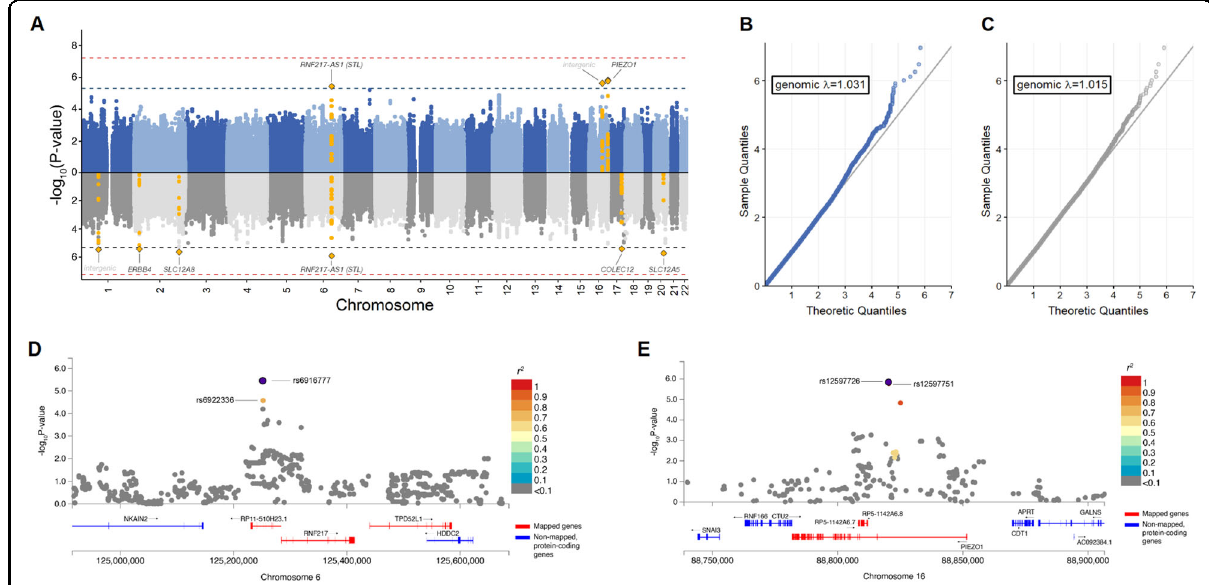
Fig. 2 Primary analysis results. A Results from the SNP-based, genome-wide association study for remission status (top panel in blue) and percentage symptom improvement (bottom panel in grey). B Q – Q plots for association p-values with remission status. C Q – Q plots for association p-values with percentage symptom improvement. D Locus zoom plot of chromosome 6 top-associated locus surrounding rs6916777 (chr6:25251374:C:A). E Locus zoom plot of chromosome 16 top-associated locus surrounding rs12597726 (chr16: